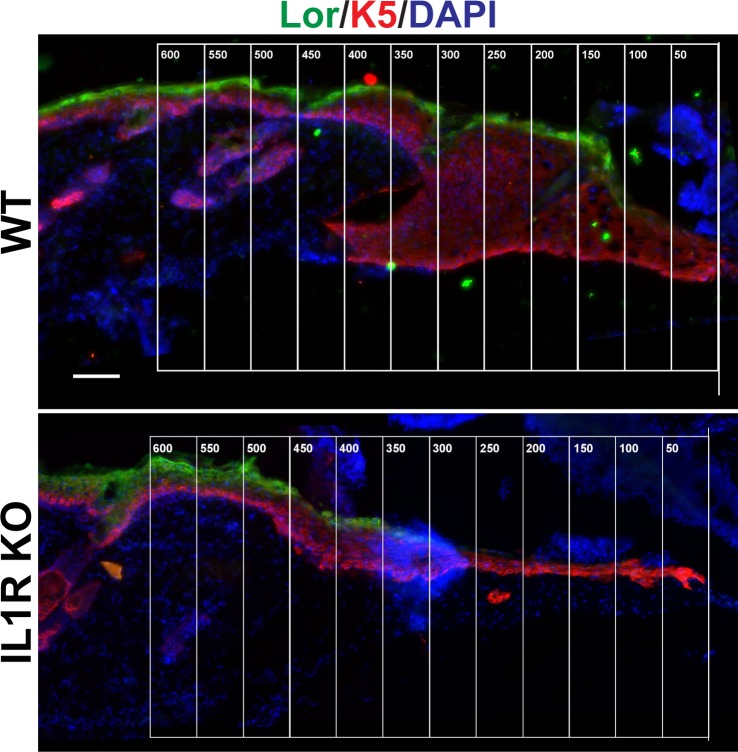
Representative image of Figure 1D.Skin sections from 8-week-old WT and IL1R KO mice were stained for keratin 5 (K5) (red), loricrin (Lor) (green) and DAPI (blue) 3 days postwounding. Epidermal thickness was calculated by taking 50-μm windows starting from the wound edge (the beginning of K5 staining), and measuring the thickness between the bottom of K5 and the top of Lor.